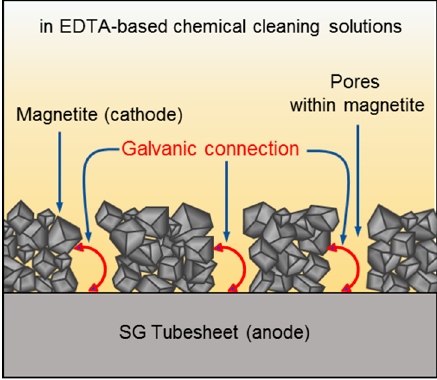
Figure 9. Schematic of a galvanic corrosion mechanism within magnetite piles accumulated on the top of the SG tubesheet during the chemical cleaning process.